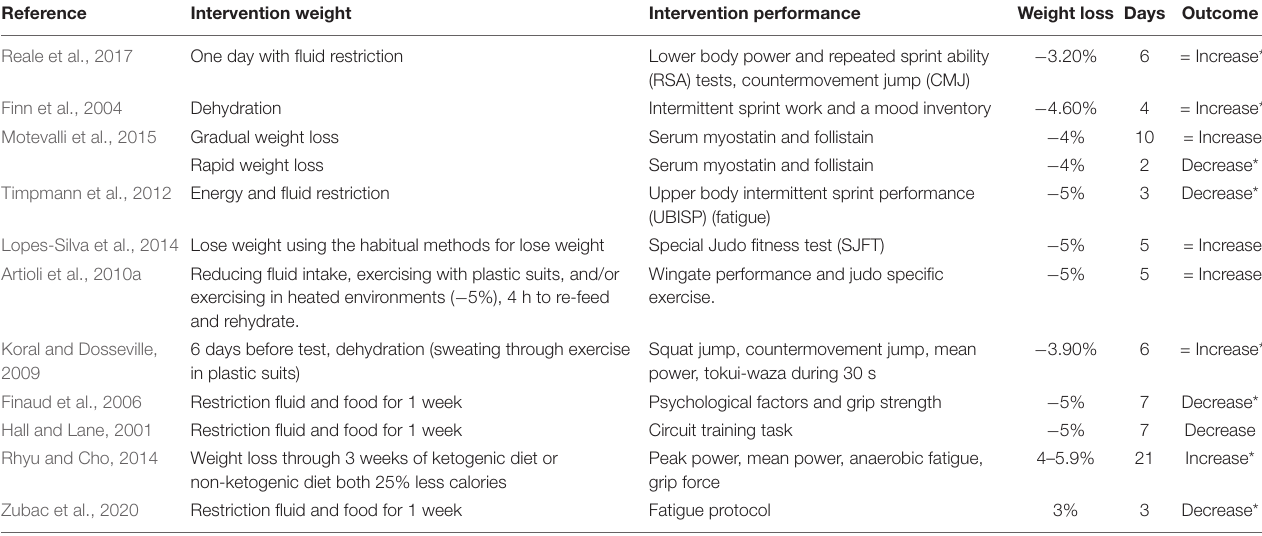
TABLE 2 | Studies included with RWL and performance-related aspects (i.e., power, strength, fatigue).